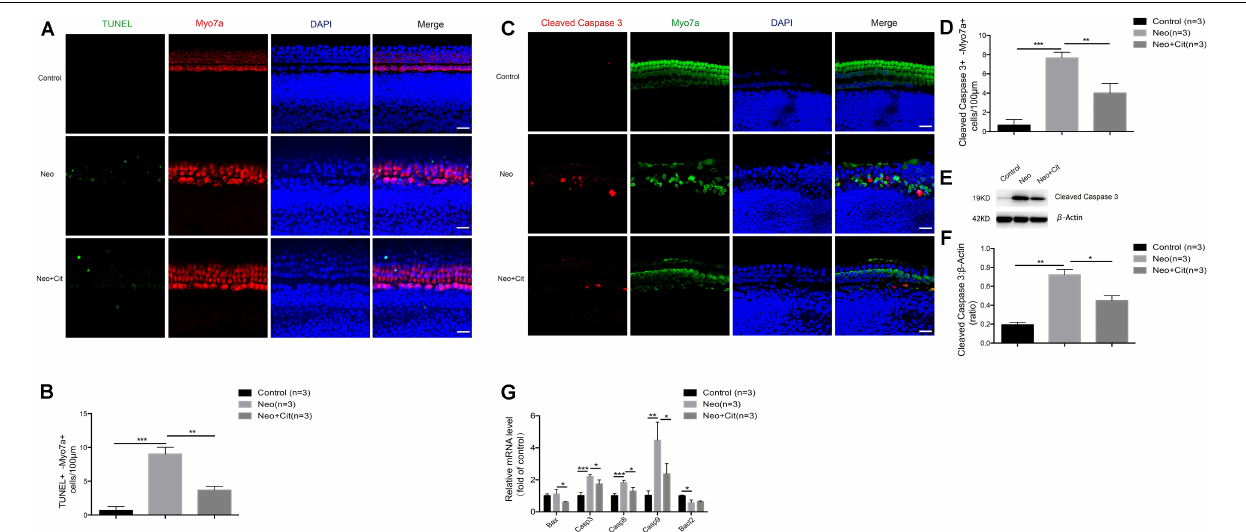
FIGURE 2 | Citicoline reduces the expression of apoptotic factors in cochlear HCs after neomycin exposure. (A) Immunofluorescence staining with TUNEL and Myo7A in the middle turn of the cochlea after different treatments. (B) Quantification of the numbers of TUNEL and Myo7A double-positive cells in (A) . (C) Immunofluorescence staining of cleaved caspase 3 and Myo7A in the middle turn of the cochlea after different treatments. (D) Quantification of the numbers of cleaved caspase 3 and Myo7A double-positive cells in (C) . (E) Western blot showing that the amount of cleaved caspase 3 in the neomycin-only group was higher than in the undamaged control. The amount of cleaved caspase 3 induced by neomycin was significantly reduced by pretreatment with citicoline. (F) Quantification of the western blot in (E) . (G) The mRNA levels of five apoptosis-related genes were analyzed by qRT-PCR after neomycin and citicoline treatment normalized to GAPDH and presented as the fold change compared to control levels. Data are shown as mean ± SD. * p < 0.05, ** p < 0.01, *** p < 0.001. Scale bars = 20 µ